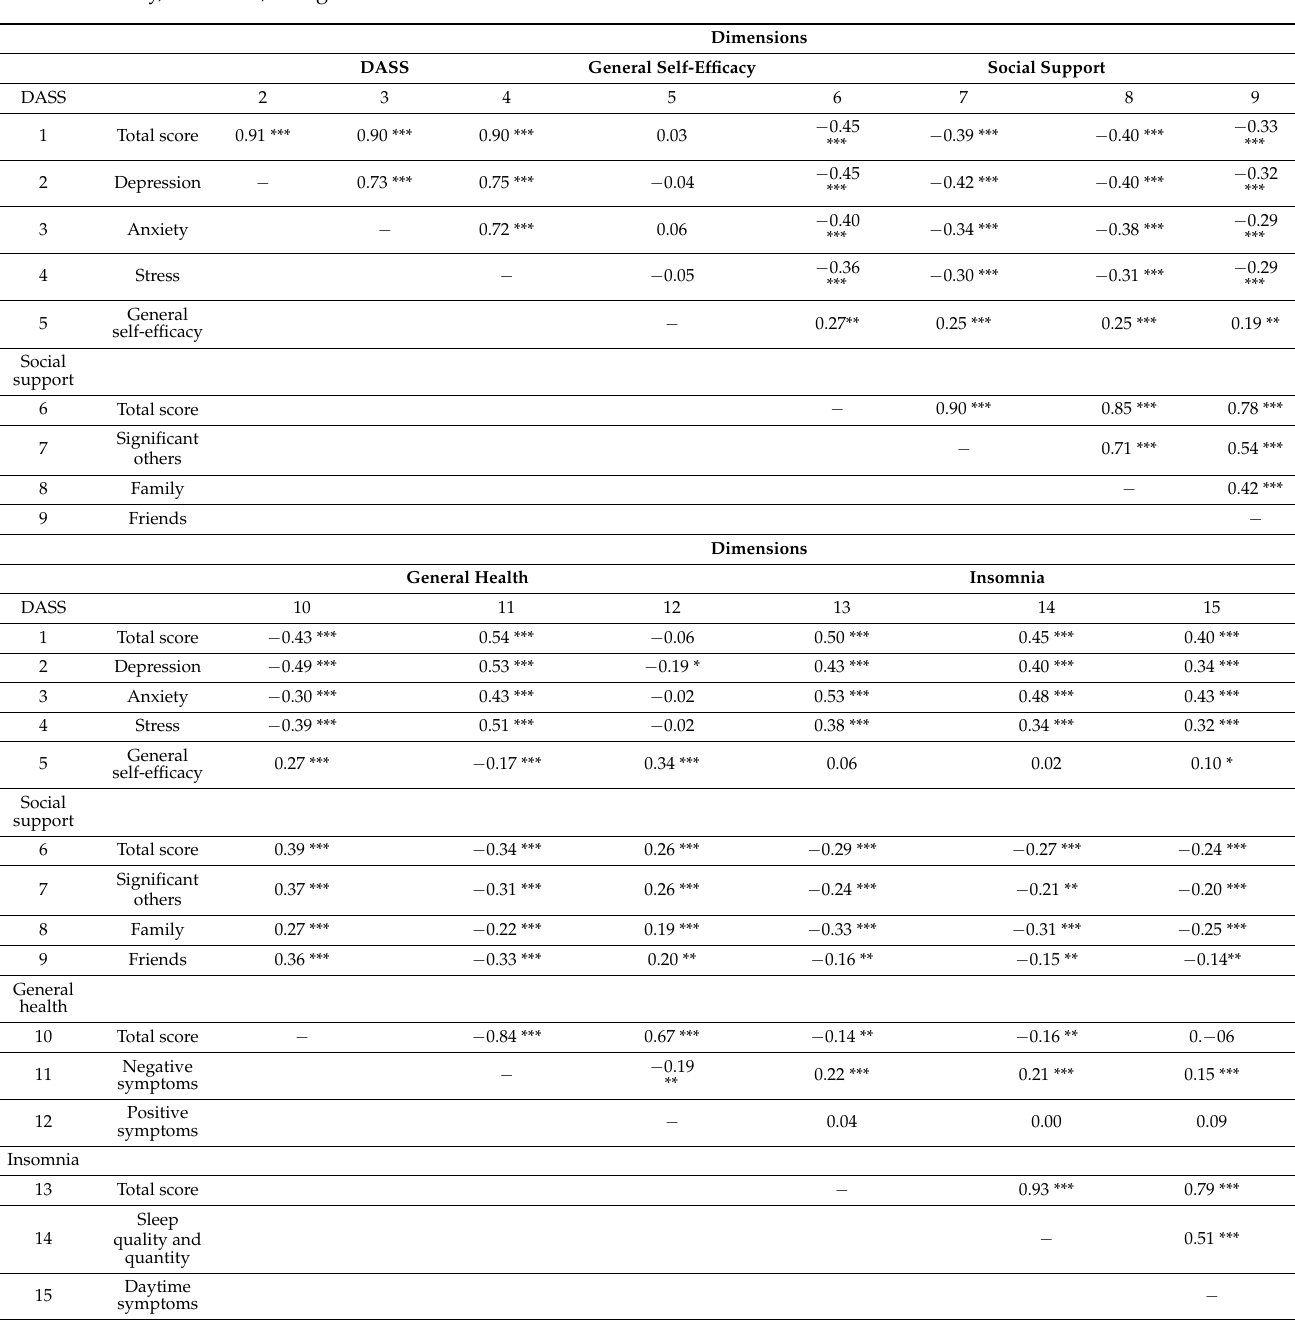
Table 2. Overview of Pearson’s correlation coefficients between dimensions of stress, anxiety, depression, social support, self-efficacy, insomnia, and general